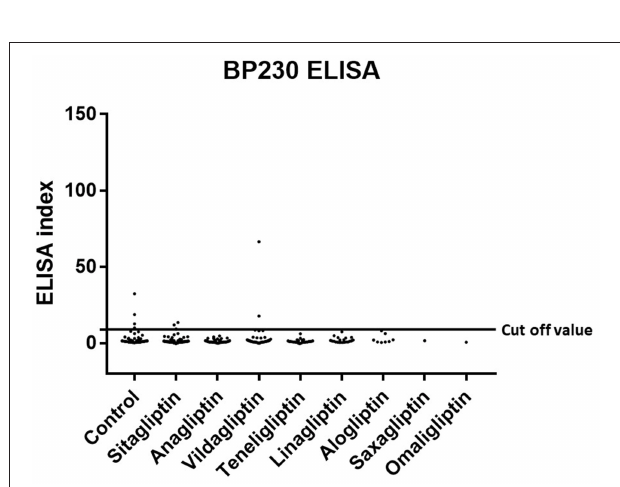
FIGURE 2 | Type 2 diabetes mellitus. Scatter plot of BP230 ELISA index in DPP-4 (–) and DPP-4i ( + ). Cut-off value of BP230 ELISA < 9.0, Control indicates the DPP-4i (–) group.